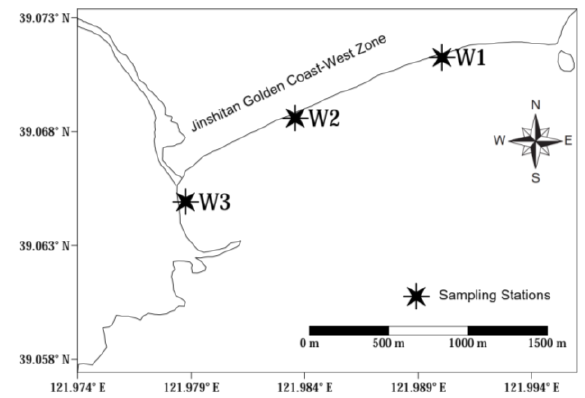
Figure 1. Sampling sites of Jinshitan Bathing Beach.